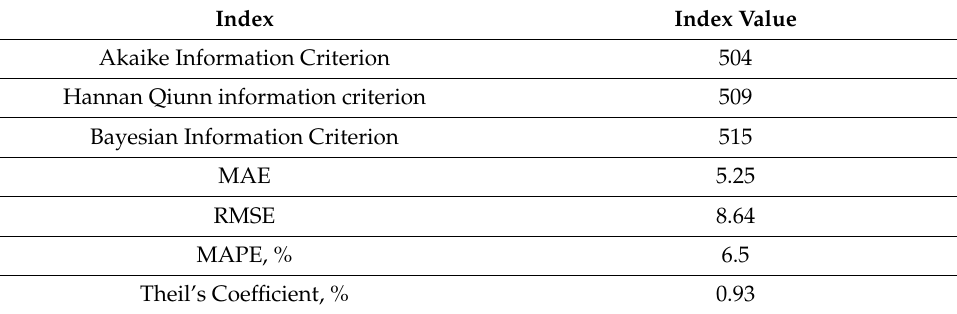
Table 4. Information criteria and ARIMA (2,1,2) model